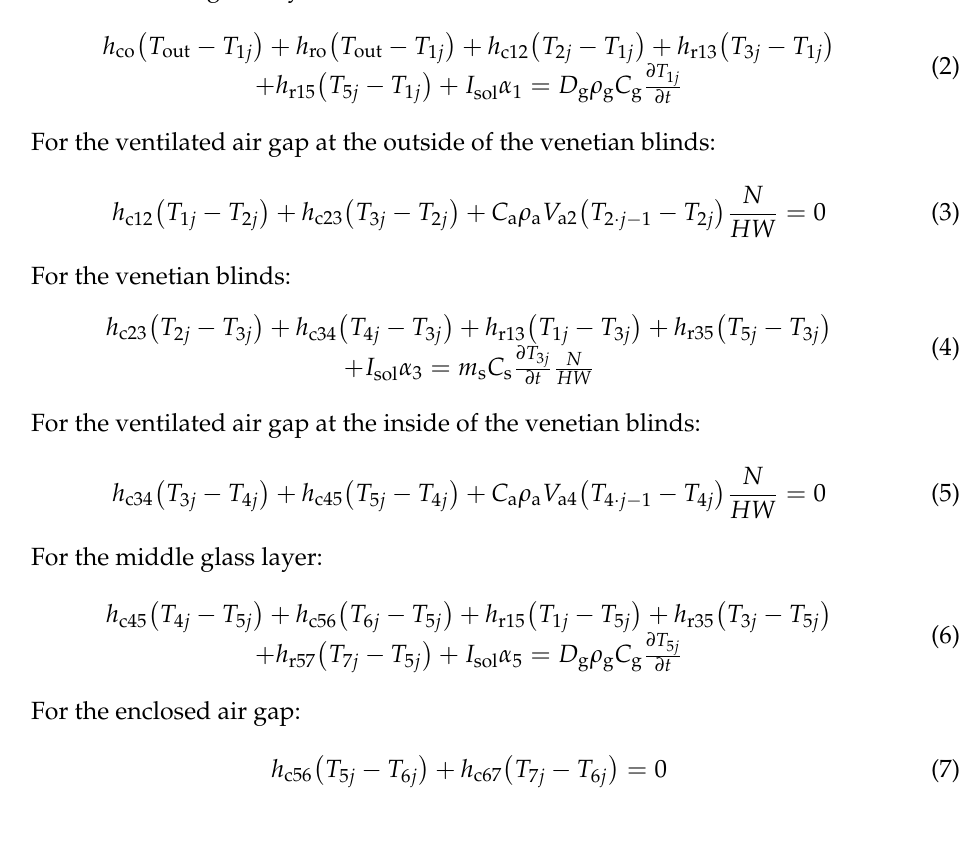
For the venetian blinds: